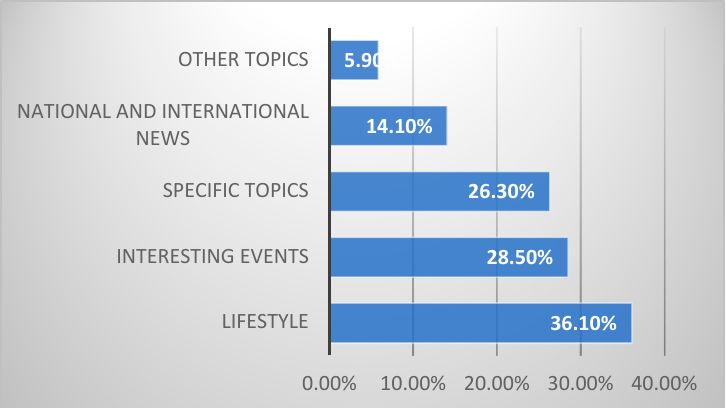
Figure 2. Graph of preferences in podcast topics among university students/Source: Prepared by the author.